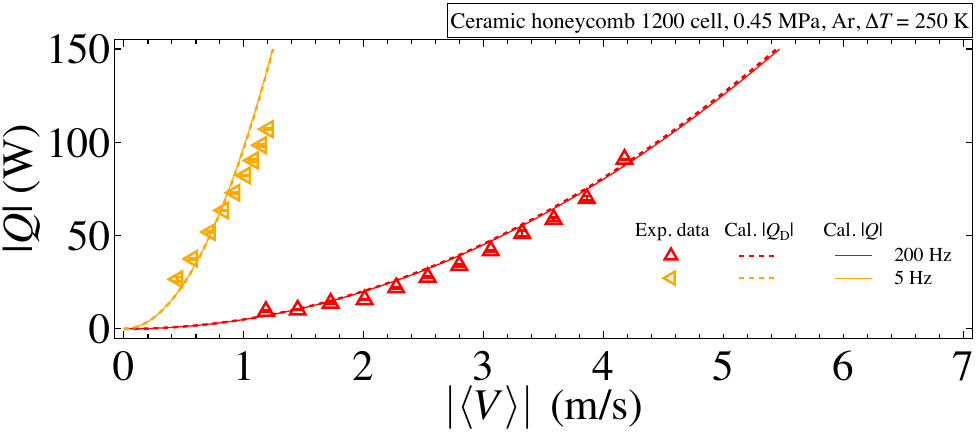
Q and theoretical calculations is given | | Q Q D and are shown, respectively, as solid | | | |